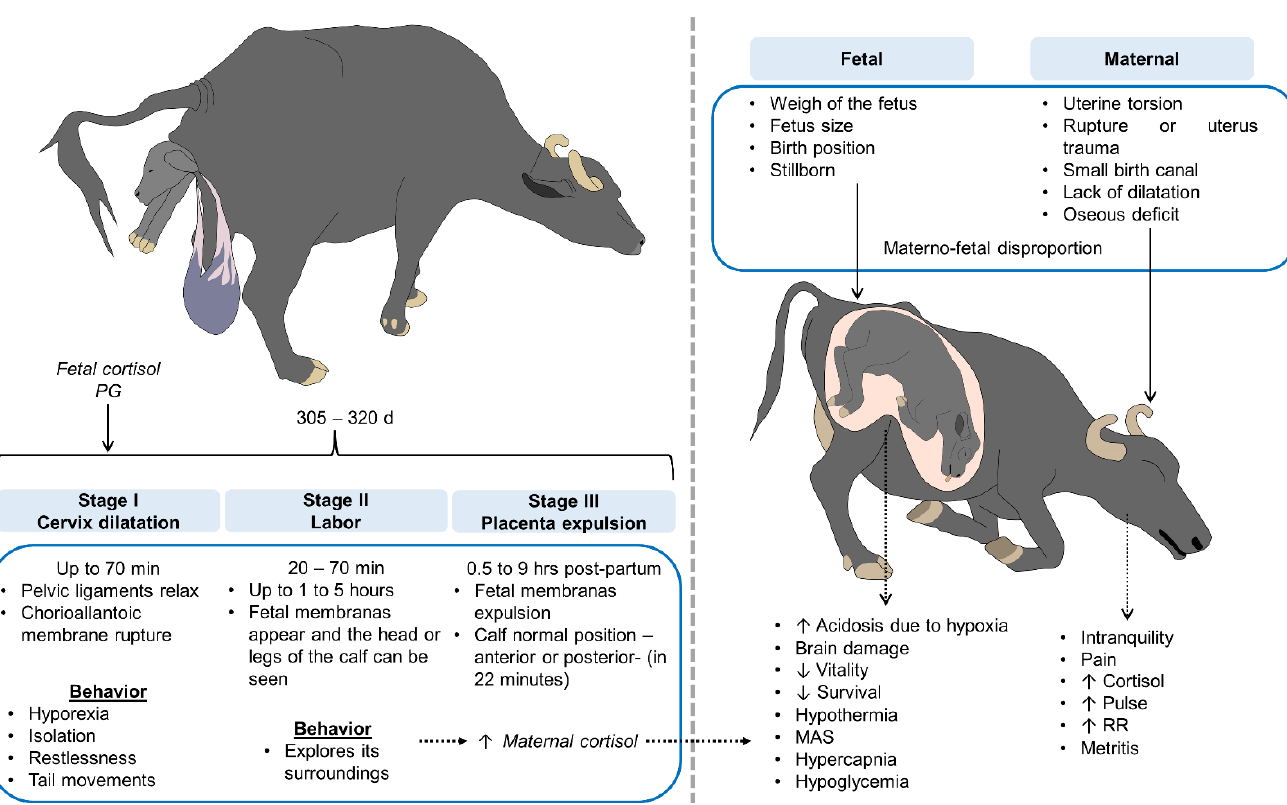
Figure 4. Stages of parturition and maternal and fetal causes of dystocia in the water buffalo. MAS: meconium aspiration syndrome; PGF2 alfa: prostaglandin F2 alpha; RR: respiratory rate.